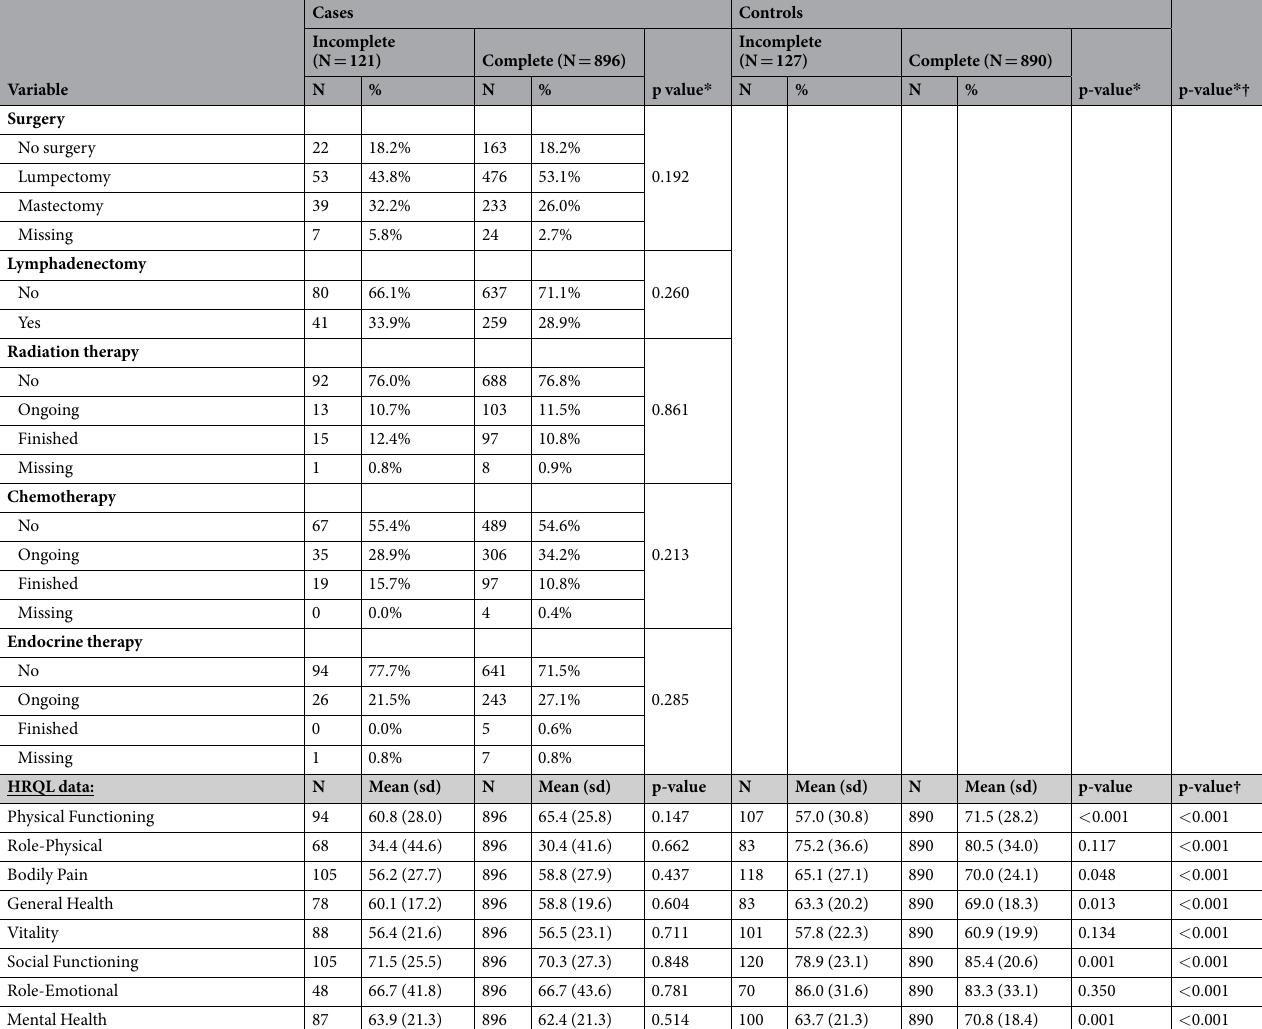
Table 1. Comparison of sociodemographic and clinical characteristics between participants with complete and incomplete response to the SF-36 and/or GHQ-28, and between cases and controls. BC: Breast cancer; BMI: Body mass index; DUFSS: Duke-UNC Functional Social Support; HER2: Human Epidermal